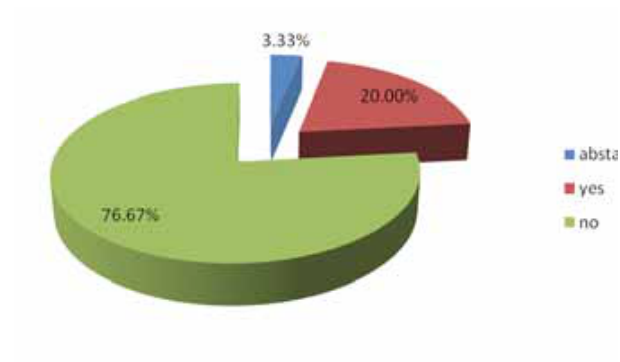
Graph 4: Percentage of Respondent Batik SMEs who knows the amount of trademark’s registration costs at DGIPR